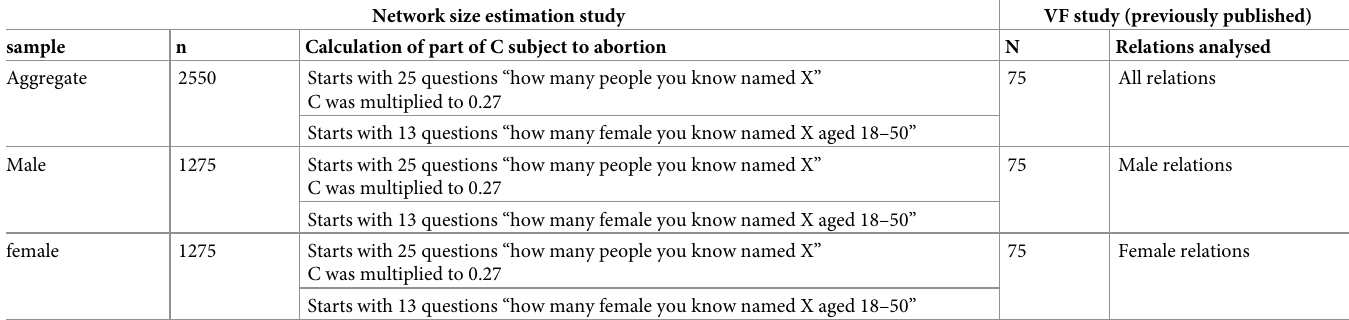
Table 1. Description of studies implements to estimate the Annual Intentional Abortion Rate (AIAR) and visibility factor. Network size estimation